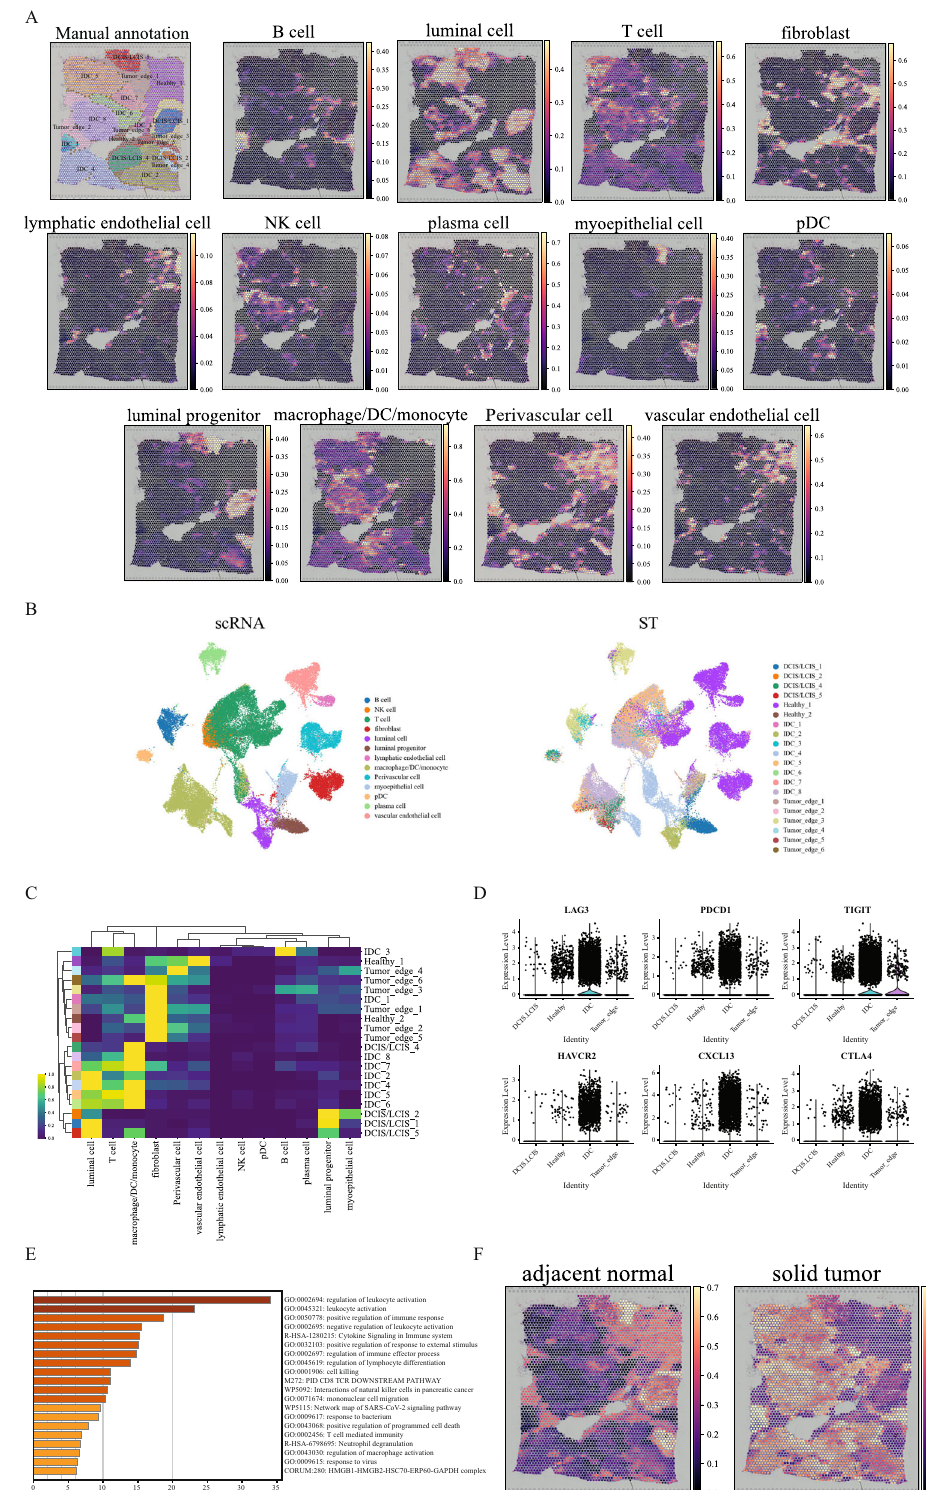
C Heatmap of the spatial distribution of cell types. D The gene expression of six T-cell exhaustion-related markers in different annotated domains. E Functional enrichment results of the IDC domain speci fi c differentially expressed genes. Sta- tistical signi fi cance was assessed by the hypergeometric test, and p -values were adjusted by the Benjamini – Hochberg p -value correction algorithm. The statistical test was one-sided. F Predicted spatial distribution of cellsfrom two sample types, adjacent normal and solid